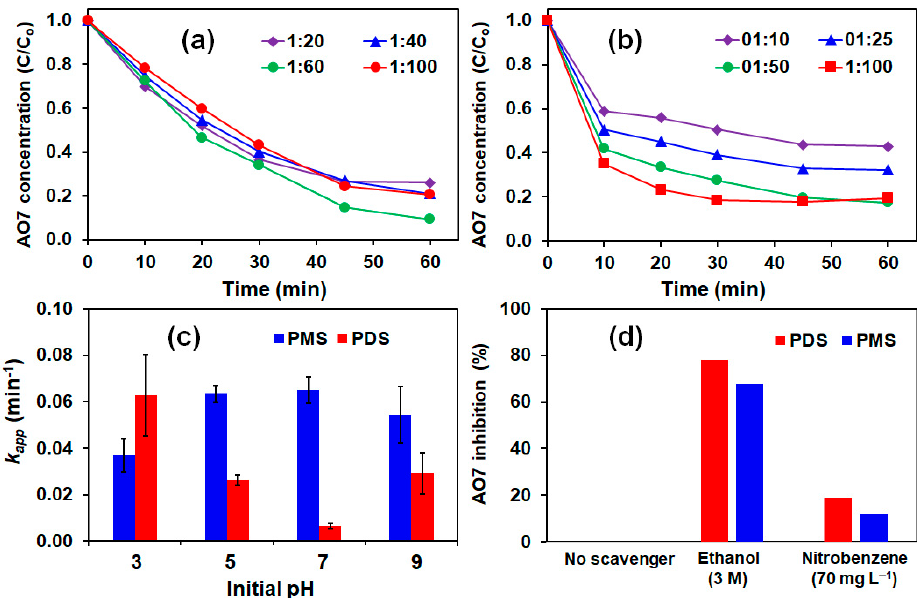
Figure 3. Effects of ( a ) PMS dosage; ( b ) PDS dosage; ( c ) pH; and ( d ) radical scavengers on AO7 removal. Conditions: [Ac-ZVI] = 2 g L − 1 , [Fe 3+ ] = 4 mg L − 1 and [PMS]/[PDS] = (for ( c , d )).